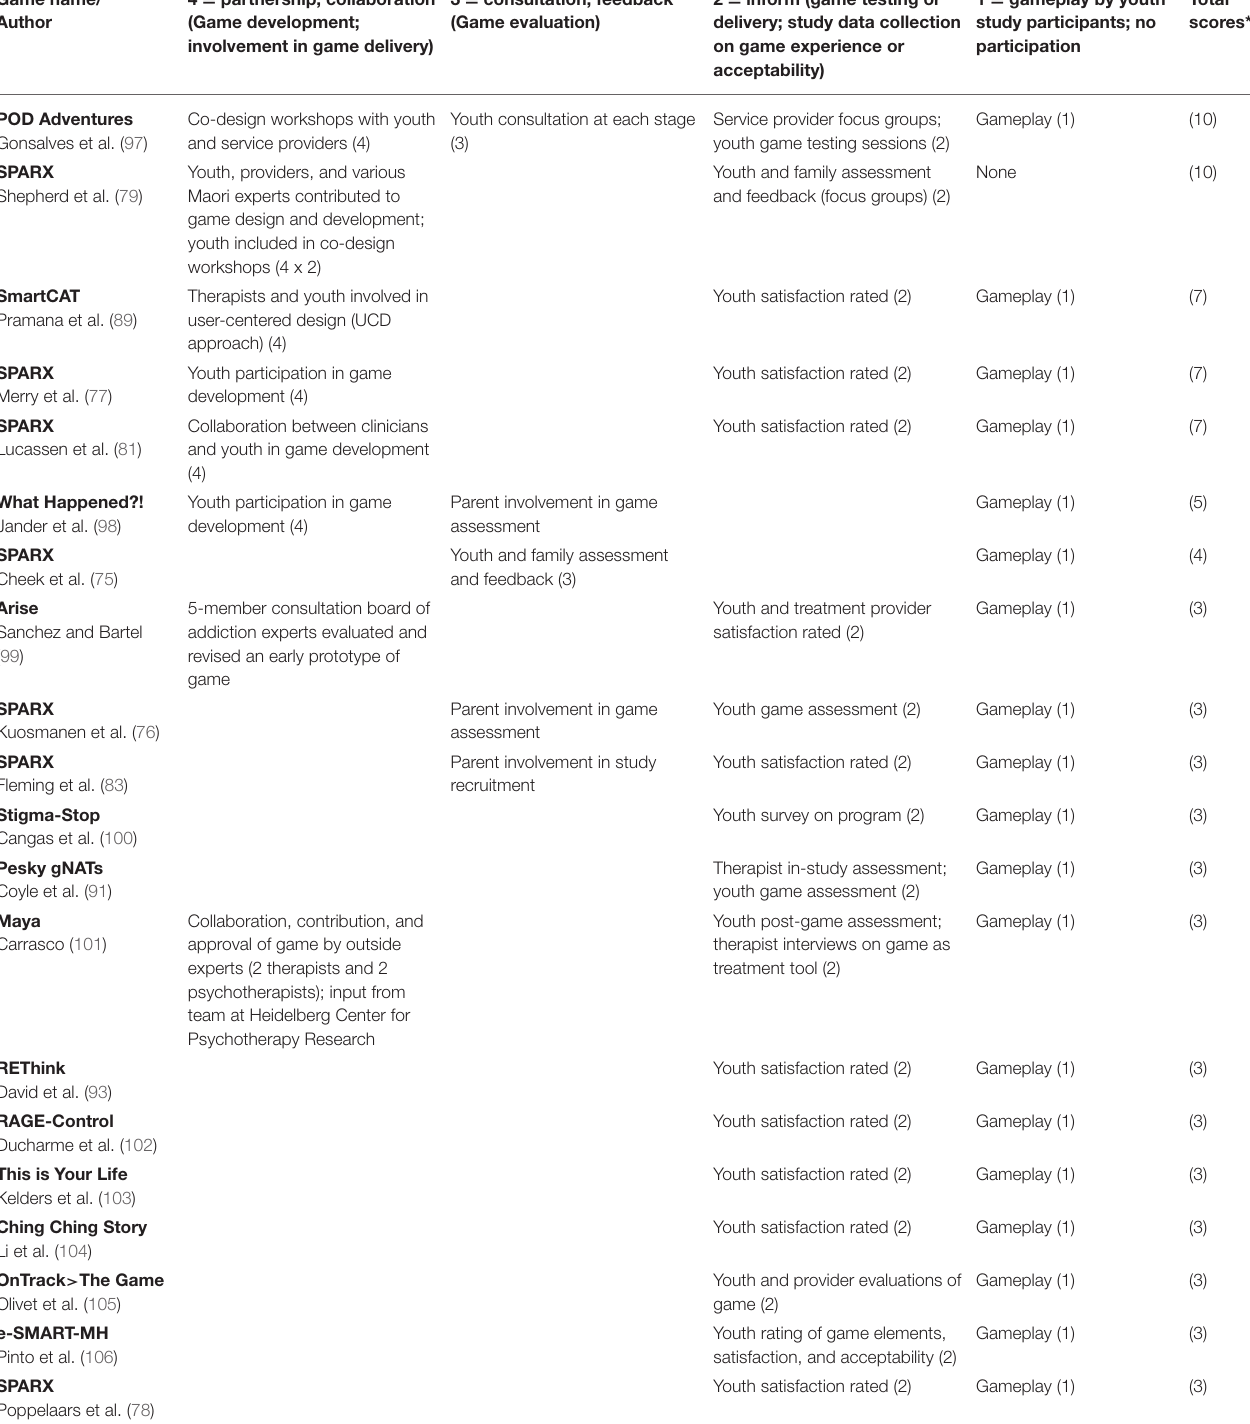
TABLE 2 | Participation data and scores on stakeholder involvement in developing, evaluating, and testing 32 videogame interventions *